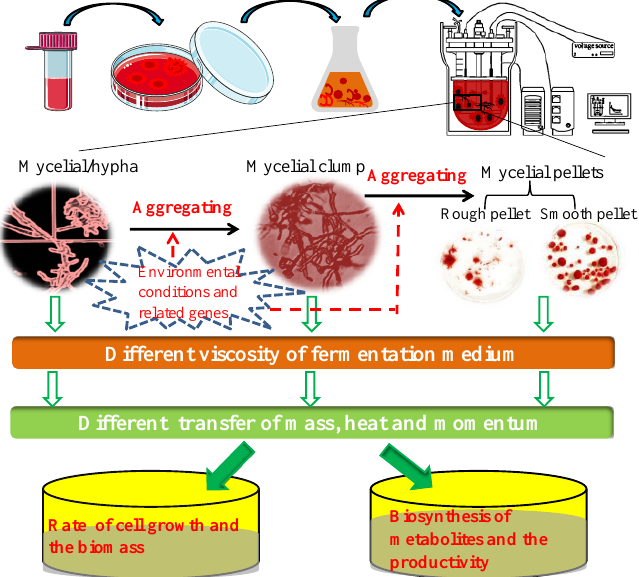
Figure 1. Mechanisms underlying the correlations among environmental conditions or genes, fungal morphology, and the production of metabolites during submerged fermentation.